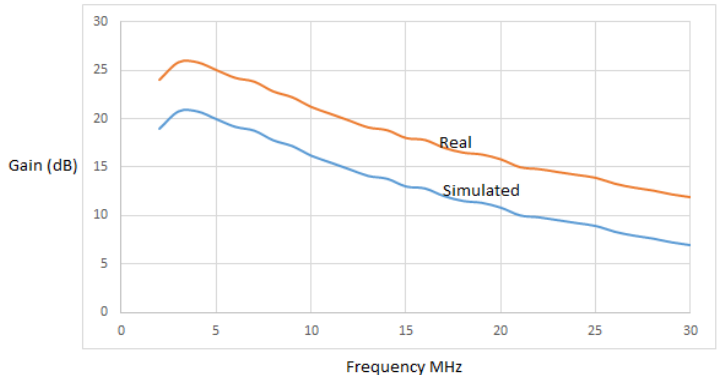
Figure 8. The LNA gain simulation by Proteous versus real gain measured in the laboratory.